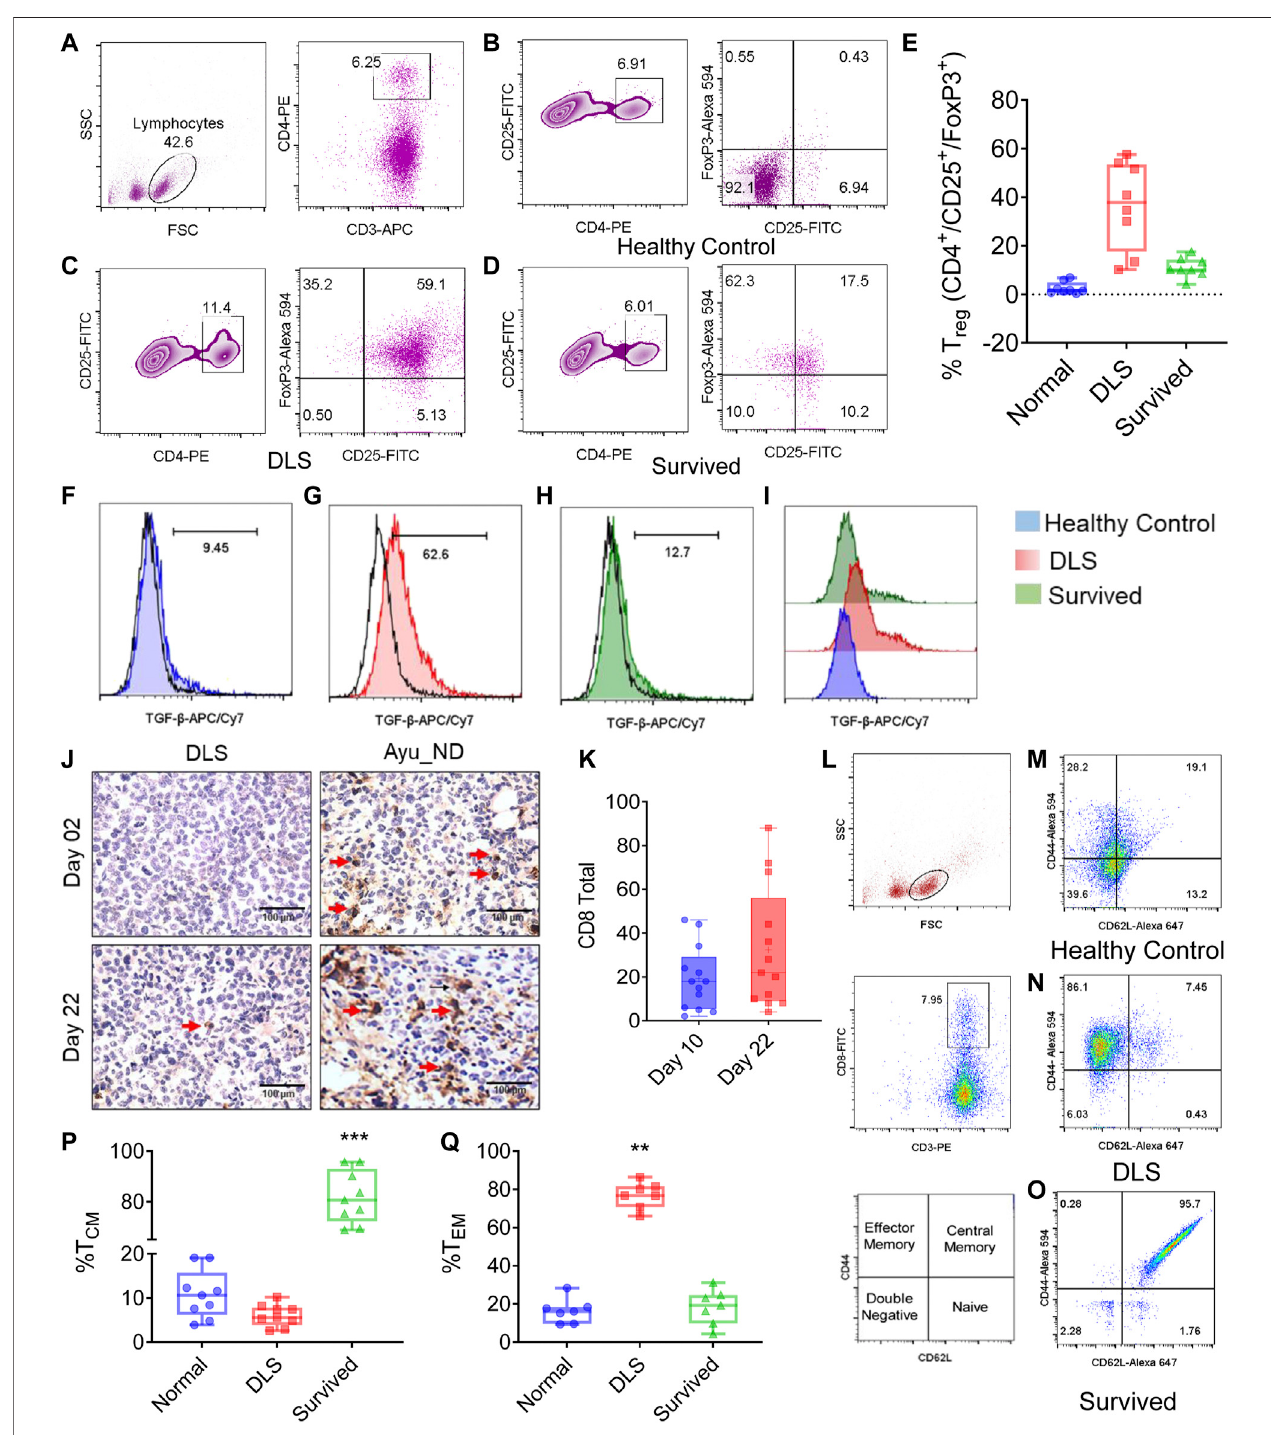
FIGURE7 | Ayu_NDabrogatesregulatoryTcellsandenhancesvaccine-mediatedCD8 + T-cellimmunity.Splenocytesfromhealthycontrol,DLStumor-bearingandtumor- freemicewerestainedforCD3 + CD4 + CD25 + Foxp3 + Tregcells.ThecellsweregatedonCD4 + CD25 + Tcells (A) .ThepercentageofCD25 + Foxp3 + cellsispresentedintheupper rightquadrantofeachplotfortheindicatedgroups (B – D) .ThepercentagesofCD25highandFoxP3 + cellsinCD4 + Tcellsareshowninrepresentativeboxplotsforhealthycontrol, untreated and Ayu_ND-treated mice (E) . Reduction in TGF- β secretion in vivo in CD4 + CD25 + Foxp3 + Treg cells following Ayu_ND treatment compared to the untreated control (F – I) . Sections of the solid tumor were stained with anti-mouse CD8 antibodies (J) . Quantitative estimation of the tumor-in fi ltrating CD8 + T cells in fi ve randomly chosen areasperslideinthreeslidespertumorandpresentedasthemean±SD (K) .GatingstrategyofCD3 + /CD8 + TcellsfromsplenocytesandrepresentationofvariousT-cellmemory subsets:naïve(TN)(CD44 − CD62L+ ),centralmemory(T CM )(CD44 +CD62L+ ),effectormemory(T EM )(CD44 +CD62L+ ),anddoublenegative(TDN)(CD44 − CD62L − )phenotypes (L – O) . Frequencies of central and effector memory T cells in untreated and Ayu_ND-treated mice (P , Q) . Data represent the mean ± SE of n = 3 or four animals per group. NS no signi fi cance; * p < 0.05, ** p < 0.01, *** p < 0.001, and **** p < 0.0001. Immunity induced by Ayu_ND treatment is long-lived.